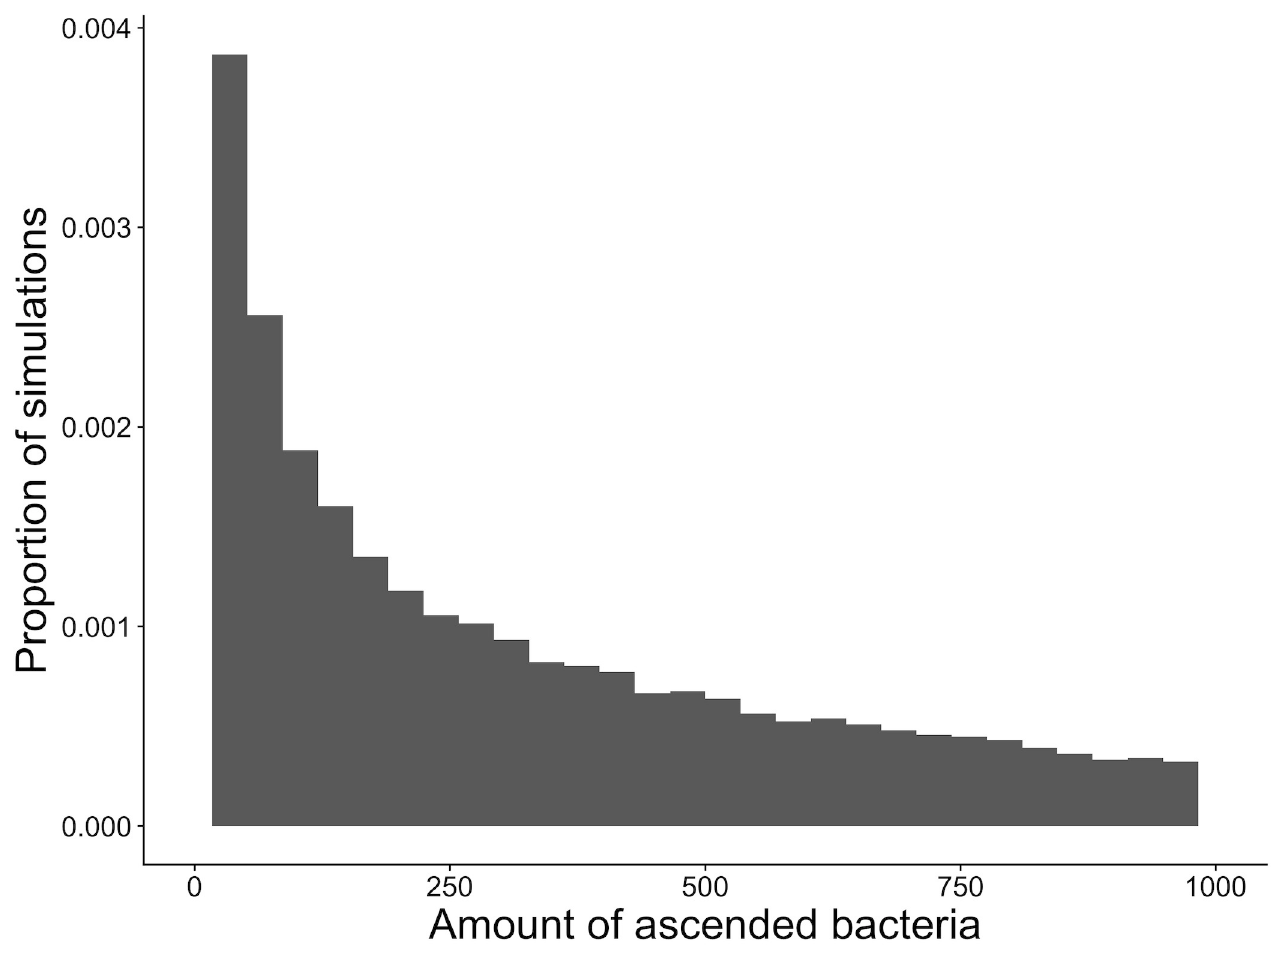
Fig 5. Histogram of the proportion of simulations leading to ascension of bacteria, and the amount of bacteria predicted by the model to ascend. The amount of bacteria predicted to ascend (x axis) and the proportions of each simulation that resulted in ascension (y axis) from 252, 500 simulations of the model. These are simulated over a range of infectious loads (10 simulations at each value of infectious load from 1 to 10001 in steps of 100.